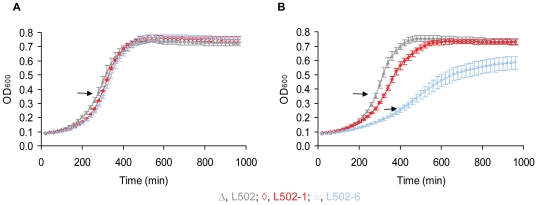
Growth of L. monocytogenes L502 and its sakacin P-resistant strains.(A) growth on cellobiose and (B) growth on mannose. The solid arrows indicate time of harvesting. The error bars represent standard errors of the mean.